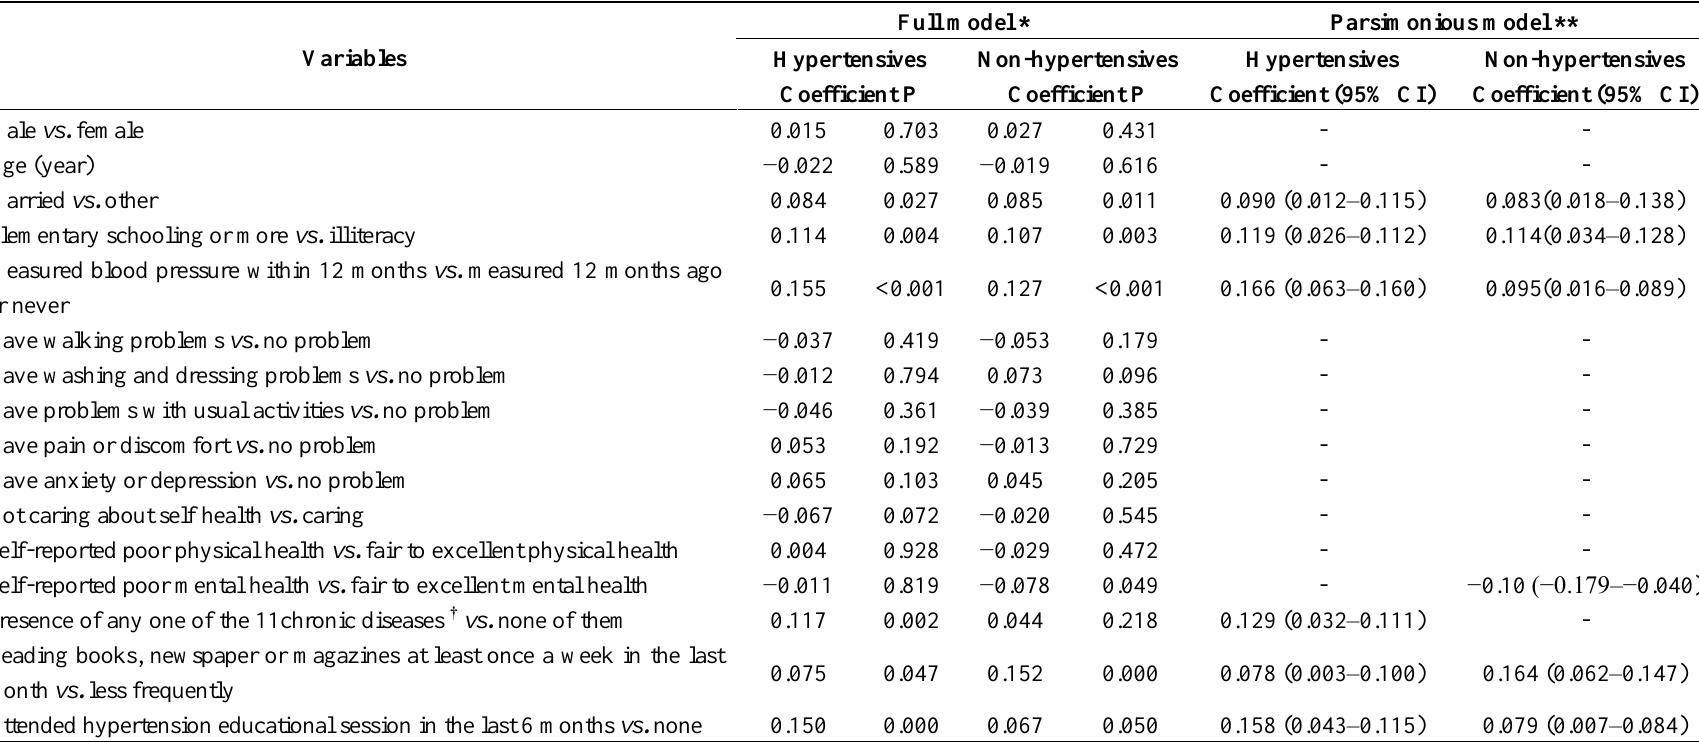
Table 4. Factors associated with hypertension knowledge level among hypertensive and non-hypertensive respondents (risk adjusted coefficient and 95% confidential interval (95%